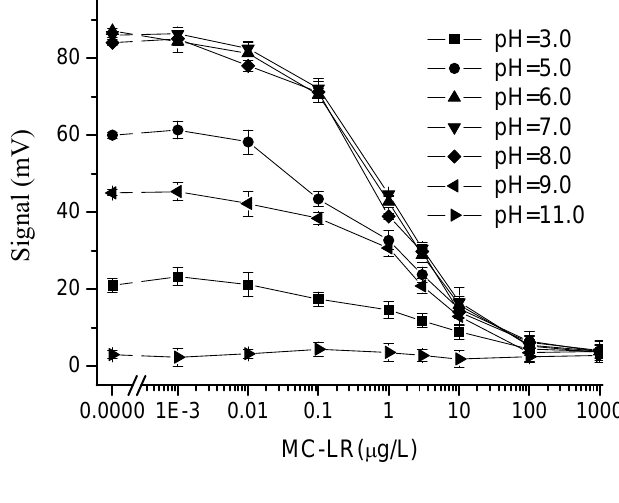
Figure 2. Effect of the pH on the MC-LR immunoassay based on EWAI. 1xPBS at different pH values were used to prepare the standard solutions and antibody solutions, respectively, and they were tested by using